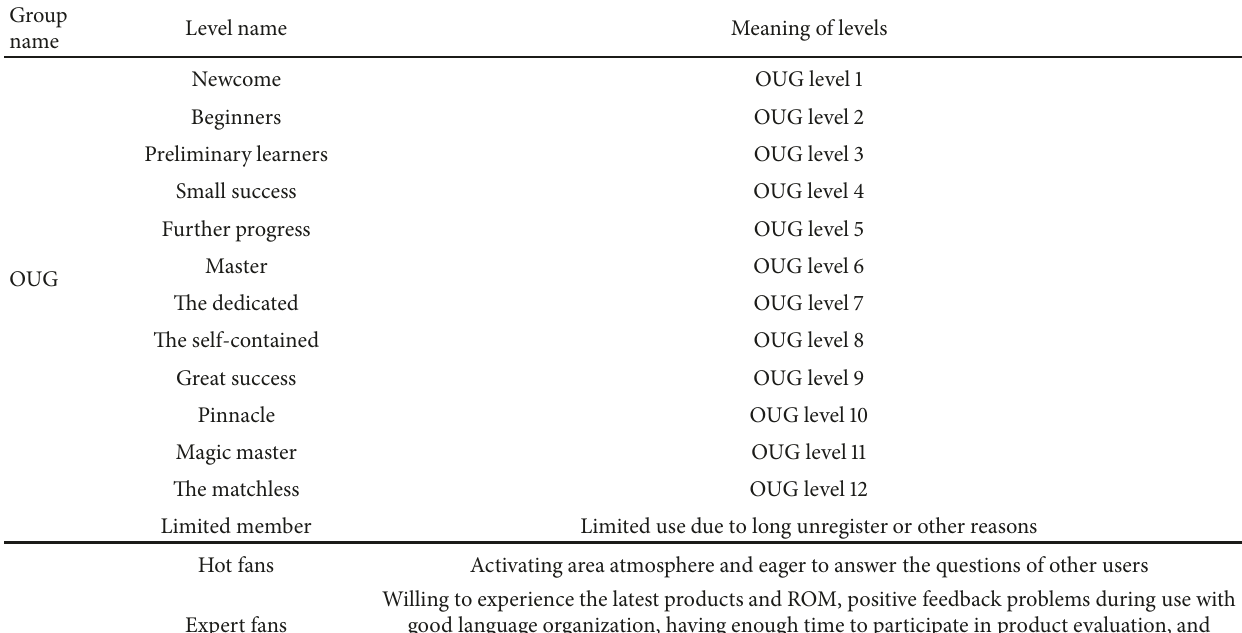
Table 2: Meaning of